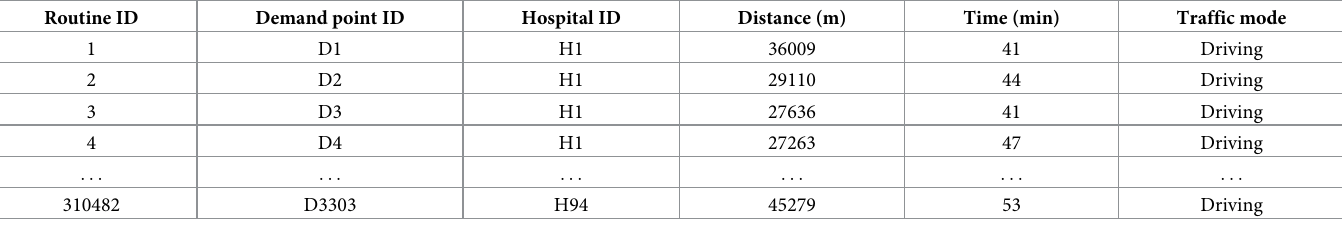
Table 1. Travel distances and times of different